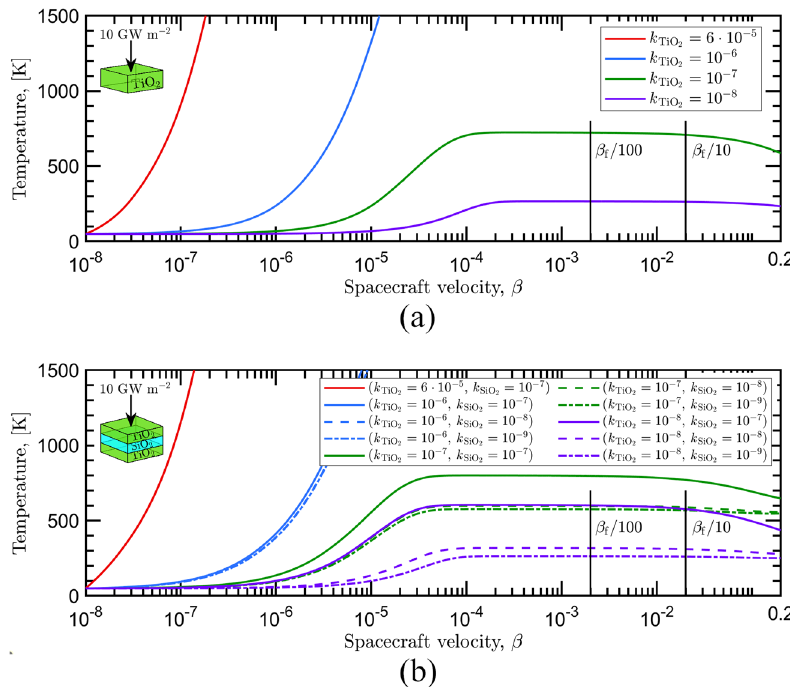
Fig. 8 TiO 2 -based lightsail temperature evolution during the acceleration phase with a laser irradicance I 0 = 10 GW m − 2 . The temperature evolution is calculated for the TiO 2 monolayer ( a ) and for the TiO 2 /SiO 2 /TiO 2 tri-layer ( b ) lightsails for different values of the extinction coef fi cients, given a starting temperature T 0 = 50 K.